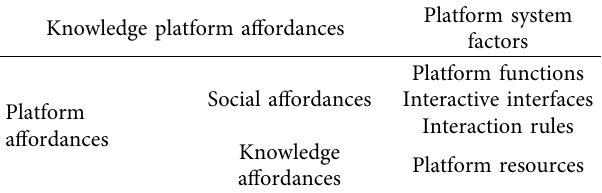
Table 1: The conceptual system of knowledge platform